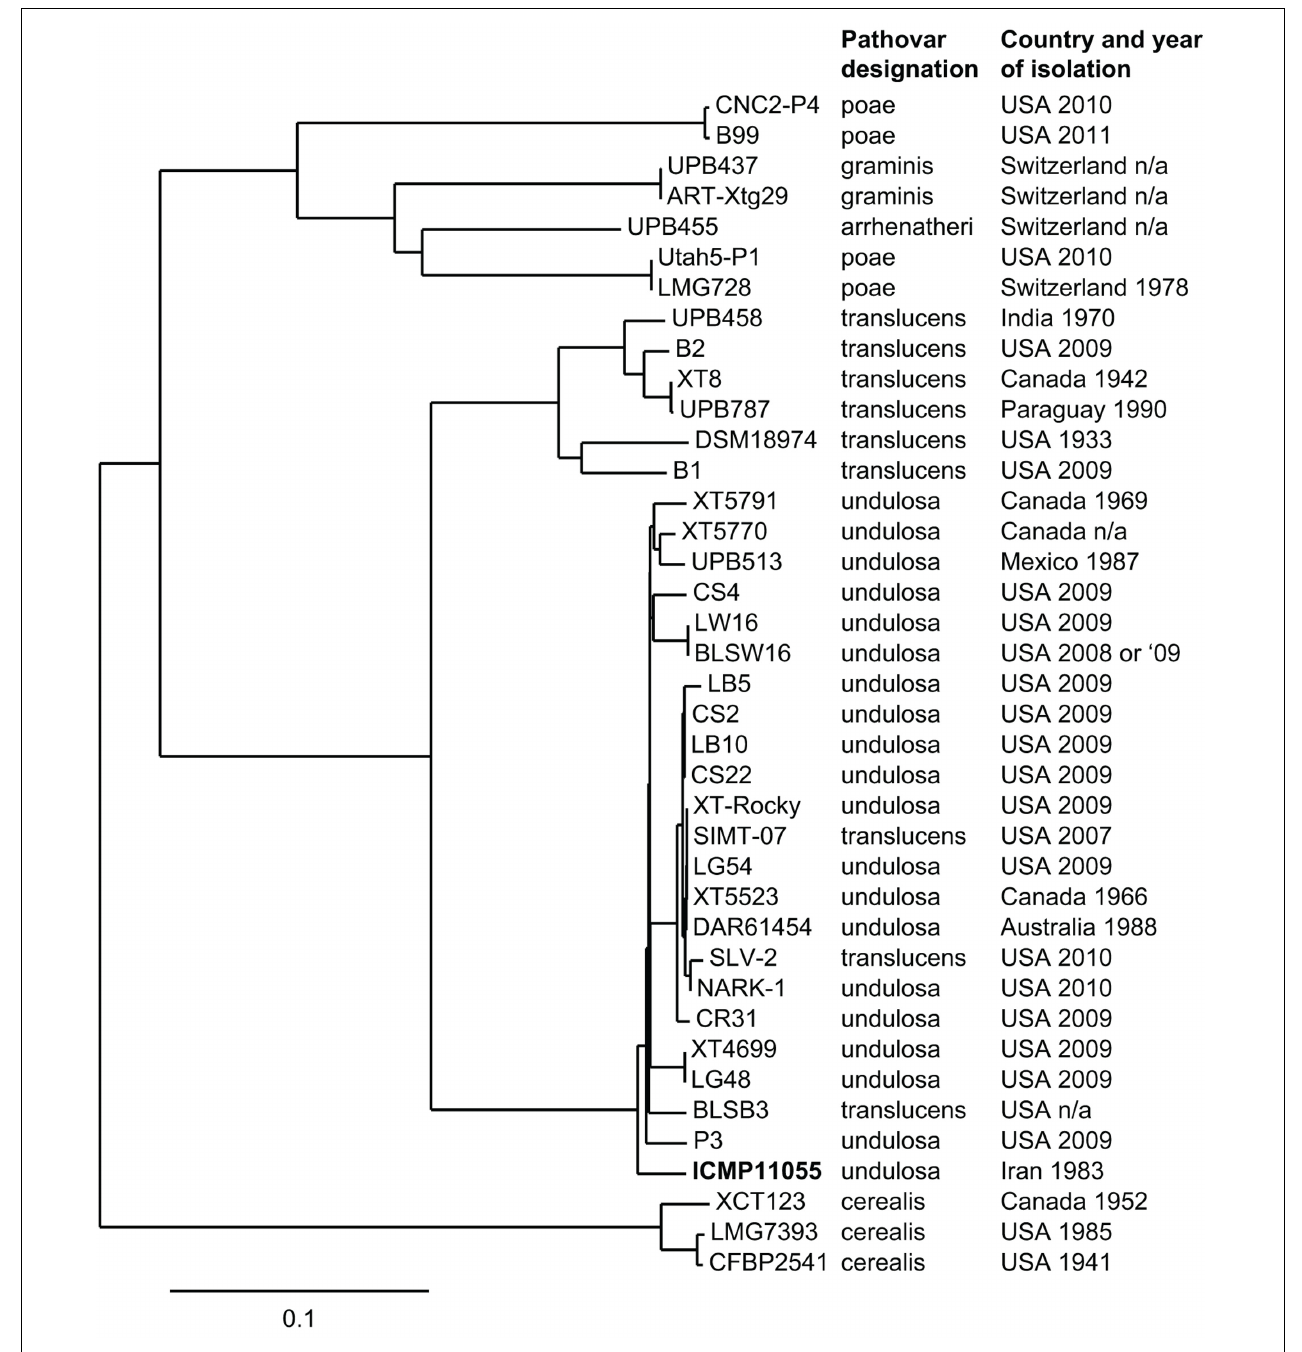
FIGURE 2 | Phylogenetic tree based on whole genome SNP analysis showing the relationship of ICMP11055 to several other X. translucens strains. To the right, the pathovar each strain was accessioned as and the country and year of isolation are provided. The sequences used for comparison to ICMP11055 were published previously (Wichmann et al., 2013; Pesce et al., 2015; Peng et al., 2016; Langlois et al., 2017). The comparison was done using the XT4699 genome as the reference.